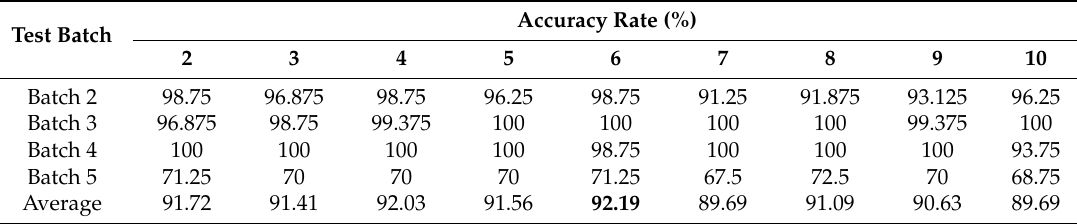
Table 4. The performance of QWKFDA using sigmoid kernel with the number of base kernels from 2 to 10.